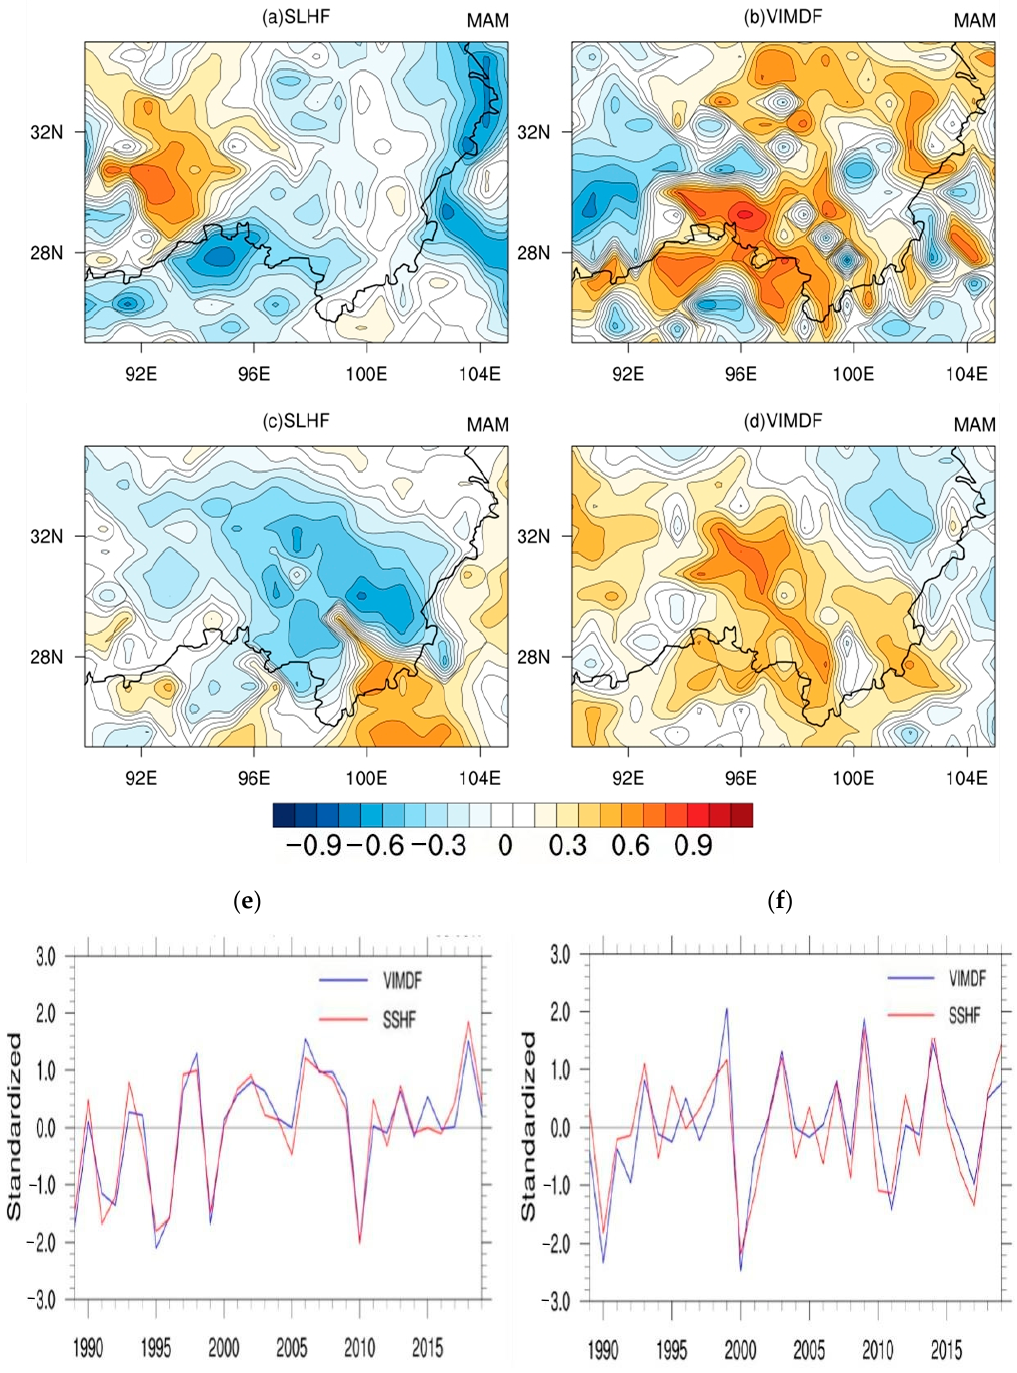
Figure 6. SVD analysis and corresponding time coefficients of the surface latent heat field and the water vapor flux divergence field in southeastern Tibet during the non-AMS ( a ) the first mode of the latent heat field; ( b ) the first mode of water vapor flux divergence field; ( c ) the second mode of the latent heat field; ( d ) the second mode of water vapor flux divergence field; ( e ) the first mode; and ( f ) the second mode. The black solid line is the boundary of the Tibetan Plateau in ( a – d ). The red solid line is SSHF time series and the blue solid line is VIMDF in ( e , f ) time series.